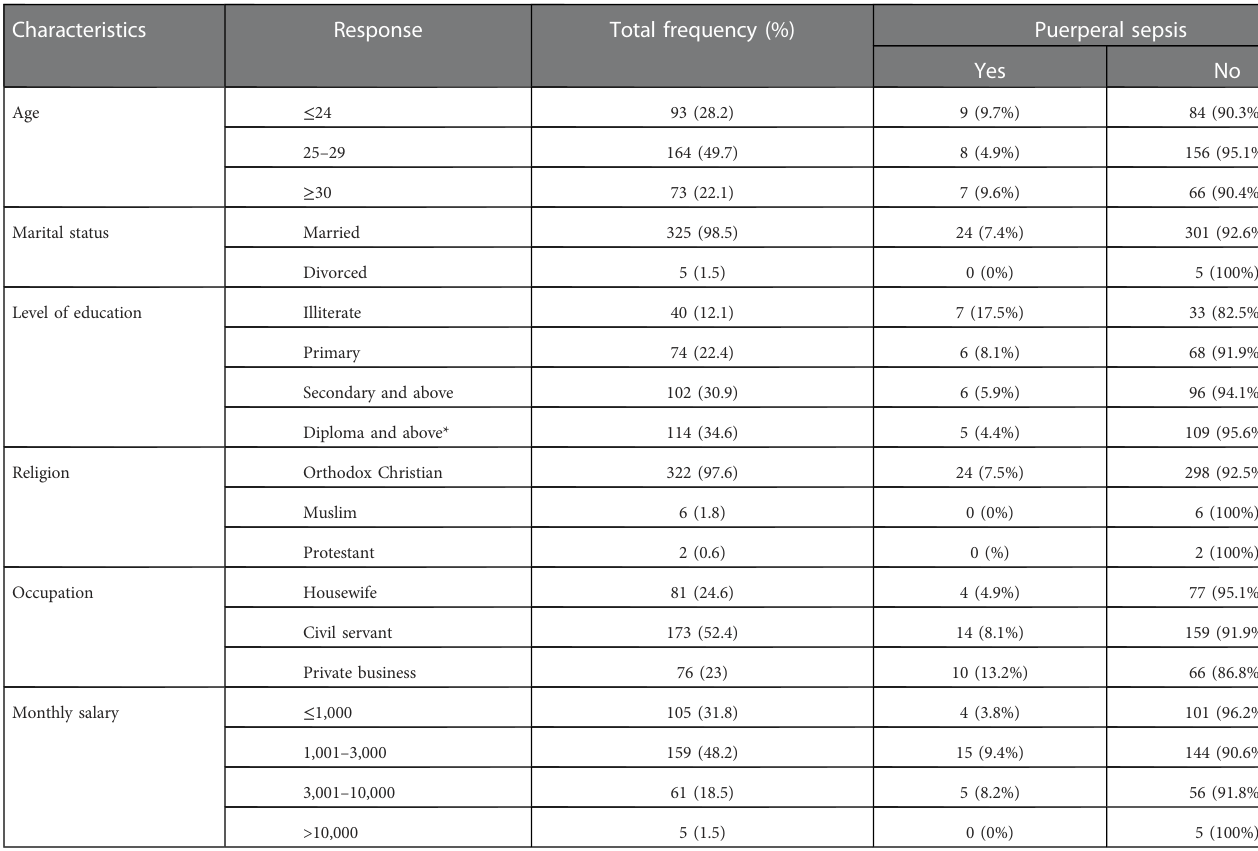
TABLE 1 Sociodemographic characteristics of study participants at DMCSH, Debre Markos, northwest Ethiopia, 2020/2021 ( N